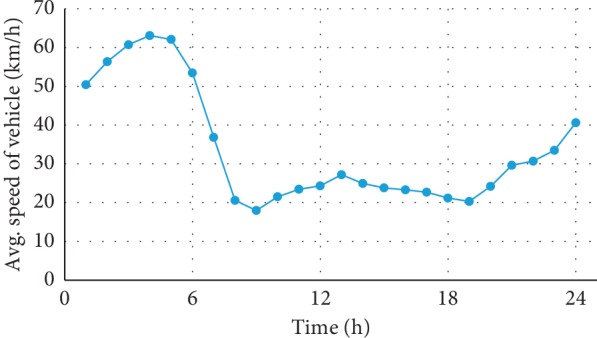
Average vehicle speeds over a day.